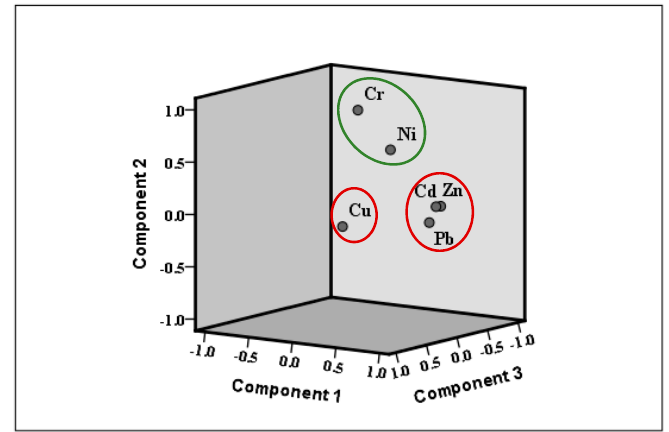
Figure5. Componentplotinrotatedspace. (Cd, Zn, Pb, andCuintheredcirclesrepresentanthropogenic Figure 5. Component plot in rotated space. (Cd, Zn, Pb, and Cu in the red circles represent sources, and Cr and Ni in the green circle represent the natural anthropogenic sources, and Cr and Ni in the green circle represent the natural source.)